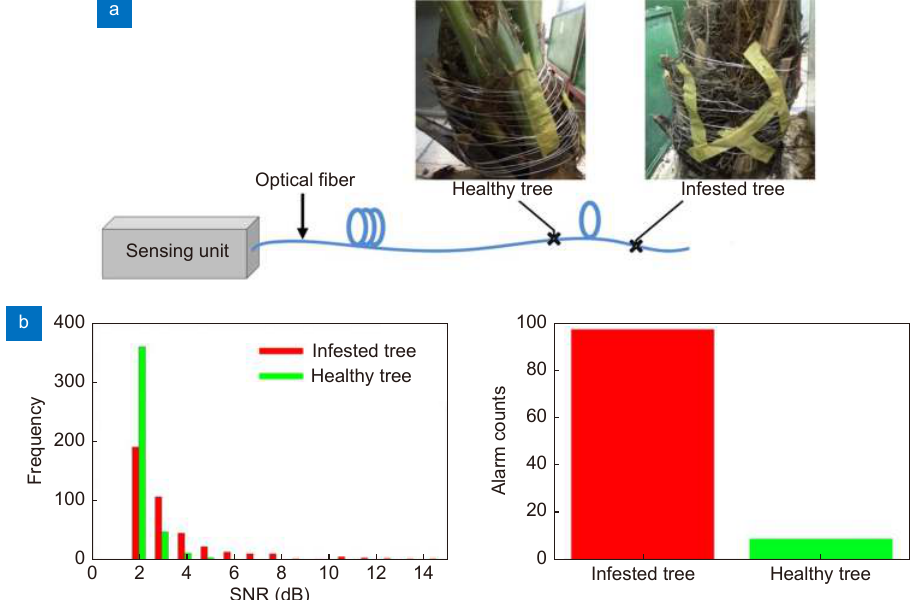
Fig. 15 | ( a ) Φ-OTDR system configuration. ( b ) Tree infestation sensing results. (Figure reproduced from ref. 182 , under a Creative Commons Attri- bution 4.0 International